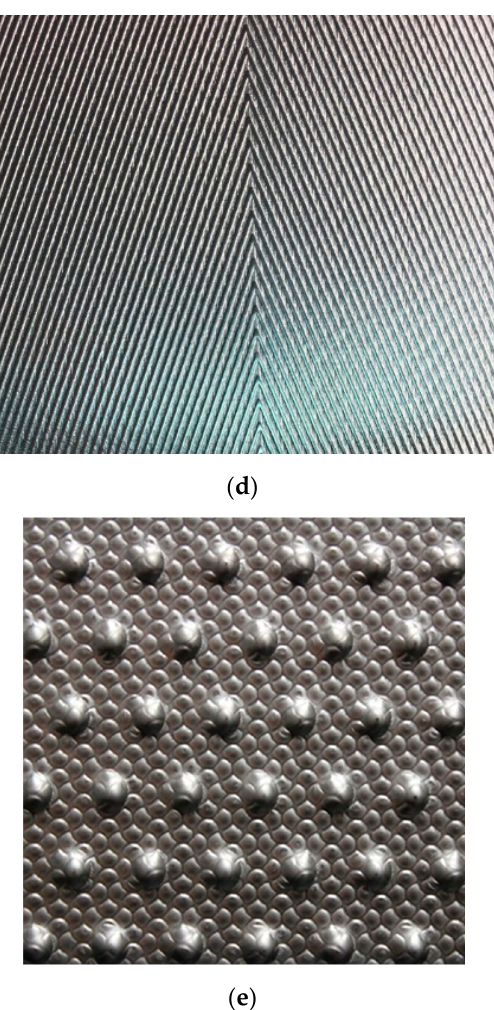
Figure 2. Surface images of the valued tubes: ( a ) EHT-HX; ( b ) EHT-HY; ( c ) EHT-HB/D; ( d ) EHT-HB; ( e ) 1EHT.